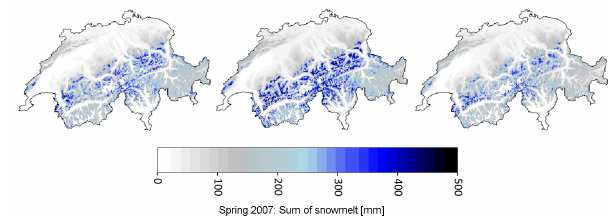
Figure 2. Cumulative snowmelt during the snowmelt season 2007 as calculated by the snow model method M1 (full model with data assimilation, left), M2 (full model without data assimilation, mid- dle) and M3 (simplified model, right). The sums between the three model methods differ depending on the use of observational snow data assimilation and the use of different DDFs.